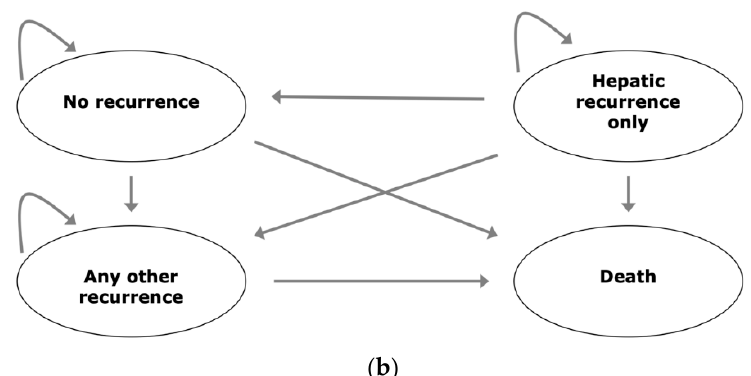
Figure 5. Model overview. ( a ). Decision model for both strategies incorporating CE-CT and 18F-FDG PET/CT. For each outcome, a Markov model analysis was performed; ( b ). Markov model with potential states “No recurrence”, “Hepatic recurrence only”, “Any other recurrence” and “Death”. The first state was determined depending on the outcomes in the decision model.